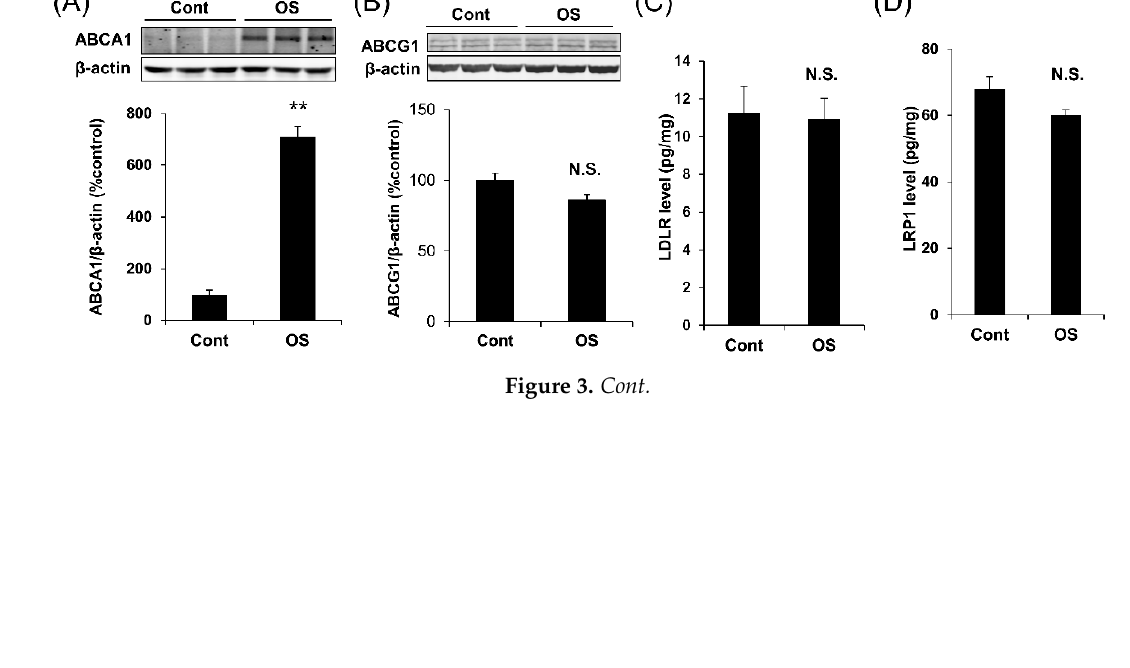
Figure 3 . OS increases ABCA1 expression and high molecular size apoE secretion. Protein levels of ABCA1 ( A ) and ABCG1 ( B ) in immortalized astrocytes derived from apoE3-TR mice were analyzed by Western blotting after treatment with OS (1 μ M) for 24 h. The graph represents the quantification of ABCA1 and ABCG1 levels. ( C – E ) After treatment with OS (1 μ M) for 24 h, protein levels of LDLR ( C ) and LRP1 ( D ) were determined by ELISA, and mRNA levels of apoE ( E ) and ABCA1 ( F ) were measured by qRT-PCR and normalized by the mRNA levels of β -actin in immortalized astrocytes derived from apoE3-TR mice. ( G ) The culture media were concentrated and then fractioned by size- exclusion chromatography on fast protein liquid chromatography (FPLC) using tandem Superose-6 columns. The concentration of apoE and cholesterol (inset) in each fraction was analyzed by ELISA and enzymatic assay, respectively. ( A – F ) Data represent mean ± SE ( A – F : n = 3, biological replicate group). ** p < 0.01, NS; non-significant; Student t -test . Importantly, geranylgeranyl pyrophosphate (GGPP), an LXR antagonist [15,16], blocked the effects of OS on apoE secretion and ABCA1 expression (Figure 4A,B). Consistently, cyclosporin A, an ABCA1 antagonist [17,18], blocked the effects of OS on apoE secretion (Figure 4C). Taken together, these results indicate that OS increases apoE secretion through the LXR-ABCA1 pathway.